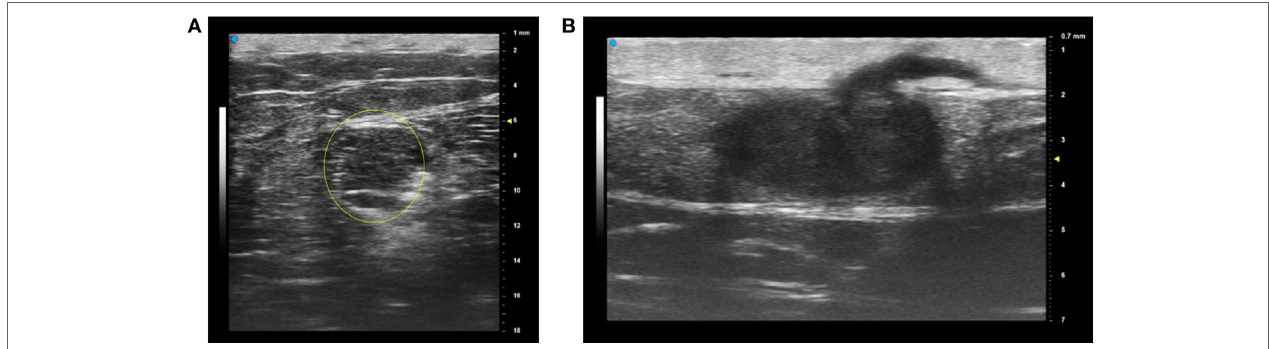
FigURe 1 | The most recent array-based ultrasound technologies for dermatology provide a choice of operating frequency, which enables the operator to “trade off” the field of view and resolution. For example, a deeper lesion (lipoma) is best imaged with a lower center frequency of 30 MHz (a) while a more superficial lesion and hair are better imaged at a center frequency of 50 MHz (B) with higher resolution but a smaller overall field of view. These images are courtesy of VisualSonics. Permissions obtained to reprint from Vevo MD for Dermatology (27), retrieved from https://www.visualsonics.com/product/imaging-systems/vevo-md Copyright 2017 Fujifilm VisualSonics